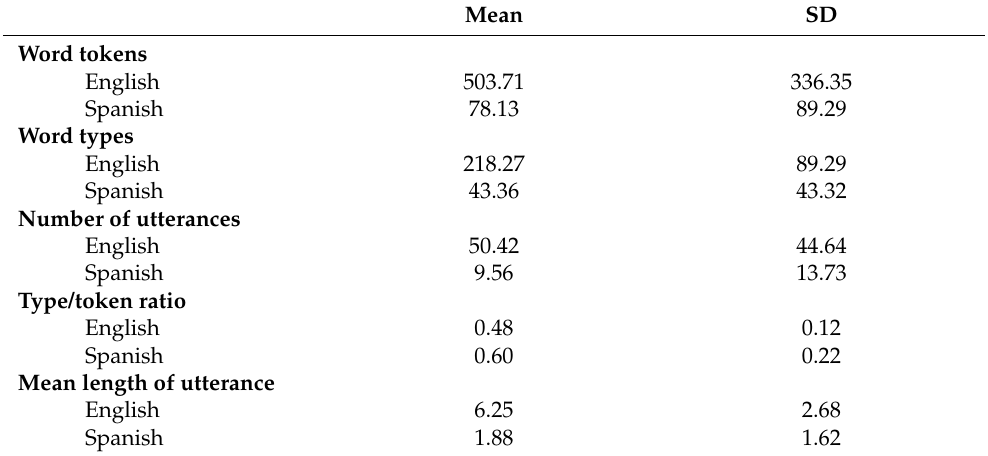
Table 1. Descriptive statistics for quantitative and qualitative features of the